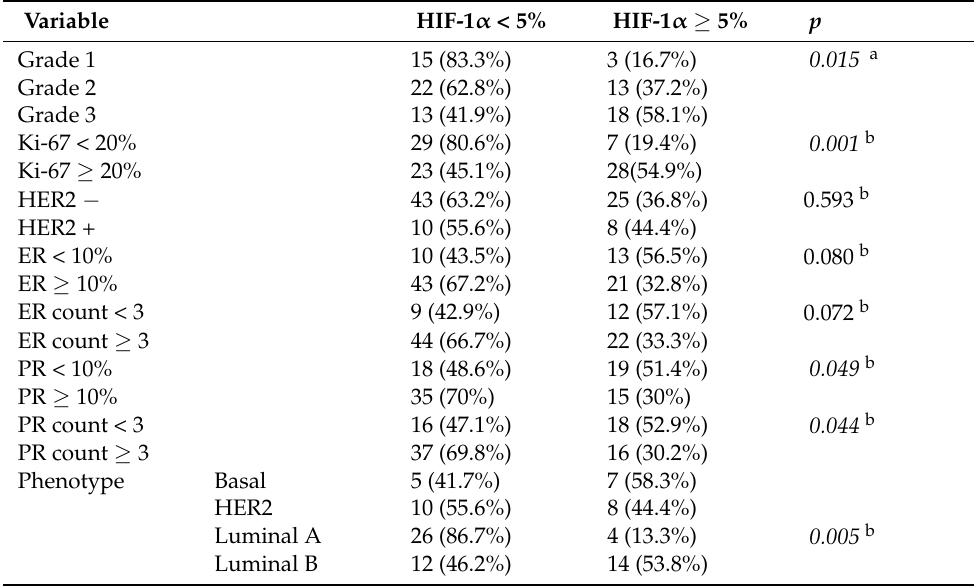
Table 3. Relation between HIF-1 α expression and clinicopathological